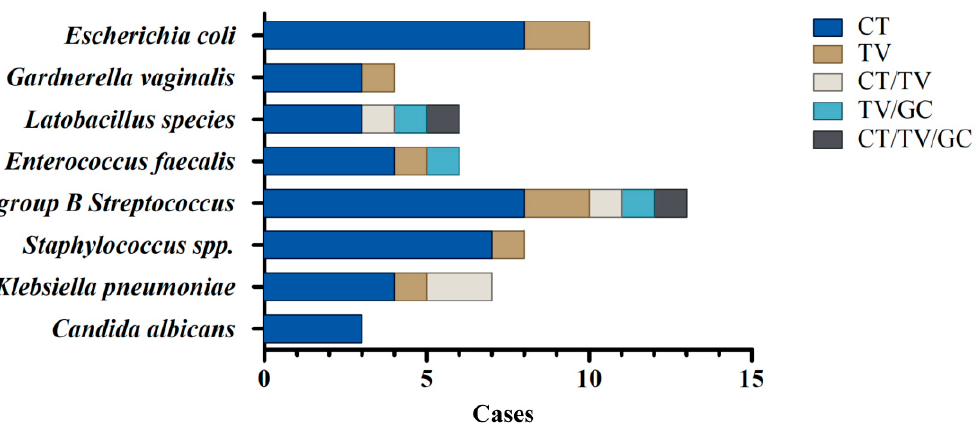
Figure 1. Identification of bacterial species co-infected with STIs by a culture-dependent method. Vaginal swabs for culture were plated on the suitable agar plates and medium. The co-existing microorganisms in each STI group were identified by phenotypic methods, Gram stains, and MALDI-TOF analysis.